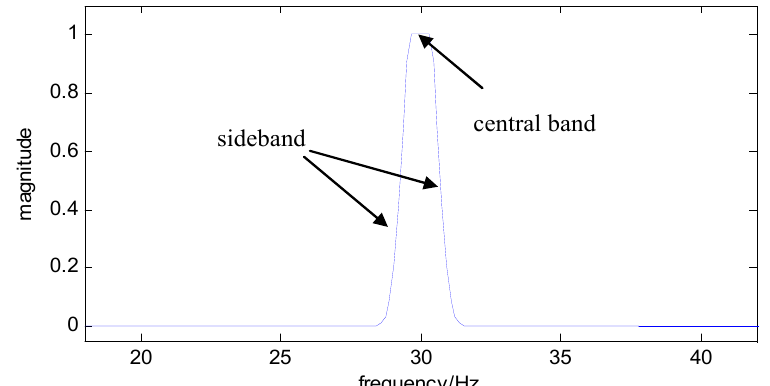
Figure 2. Frequency-domain plot of a comblet with one tooth.